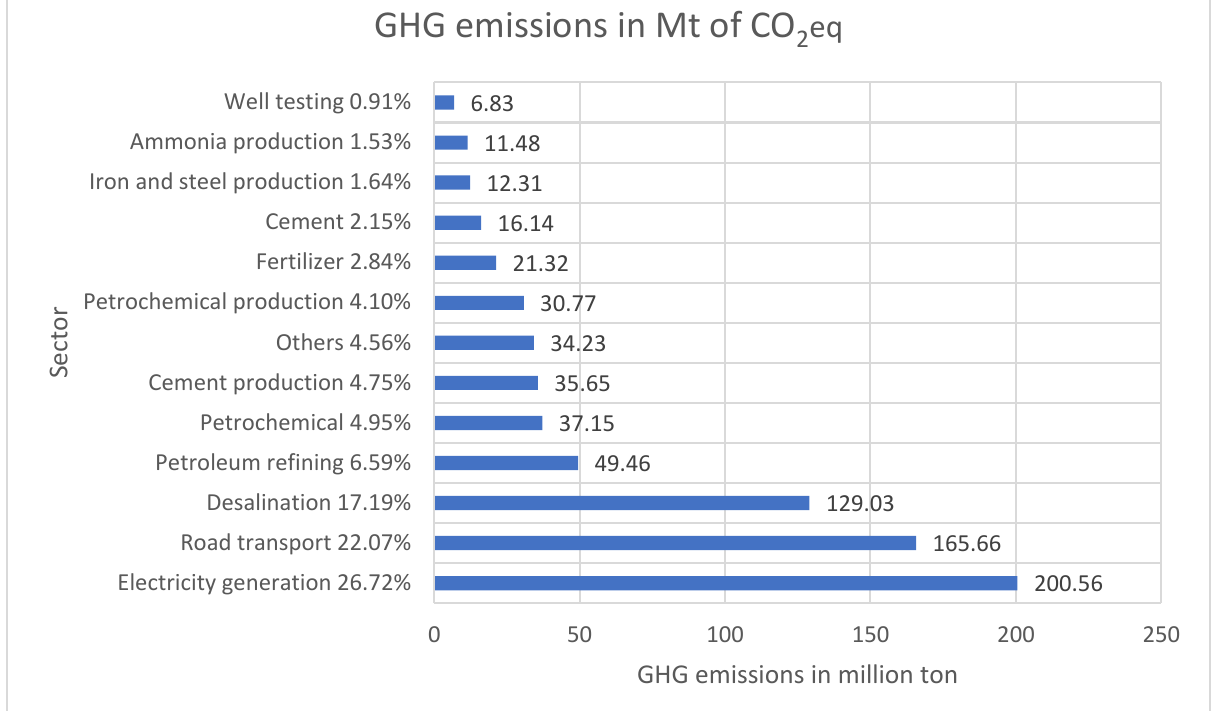
Figure 8. GHG emissions estimate in 2018 by sector.